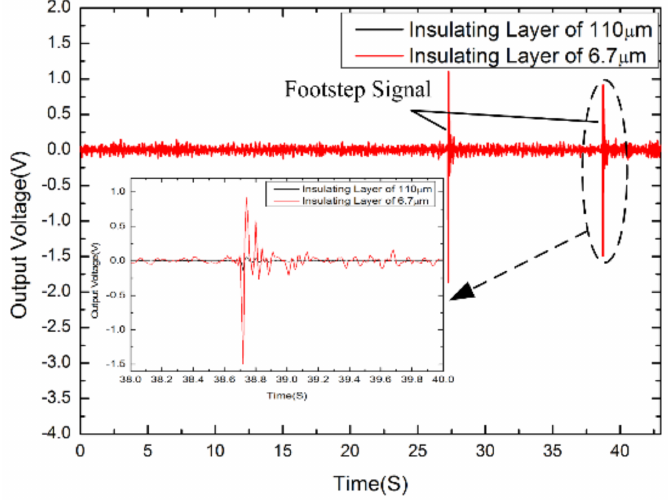
Figure 5. The inputs of footsteps were detected by the parylene vs. silicon based electrochemical seismic sensors, respectively. The source of footsteps was 2 m away from the devices. The peak responses of the parylene based seismic sensors were about 13.3 times (27.26–27.28 s) and 12.5 times (38.72–38.74 s) more than the seismic sensors based on the silicon substrates in response to two inputs of